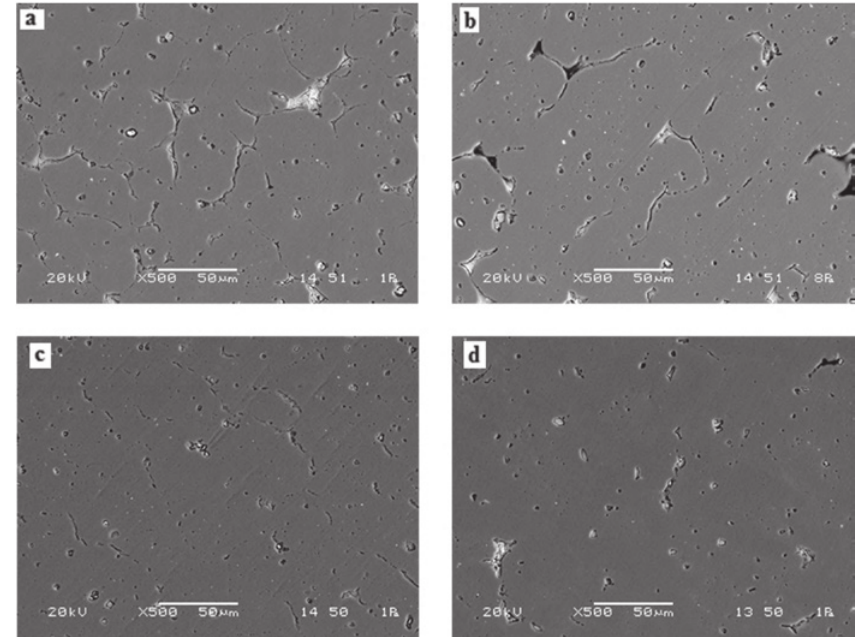
Fig. 4: The SEM Microstructure of the ECAP’ed and thixoformed AA7075; 1 passed (a), 2 passed (b), 3 passed (c) and 4 passed